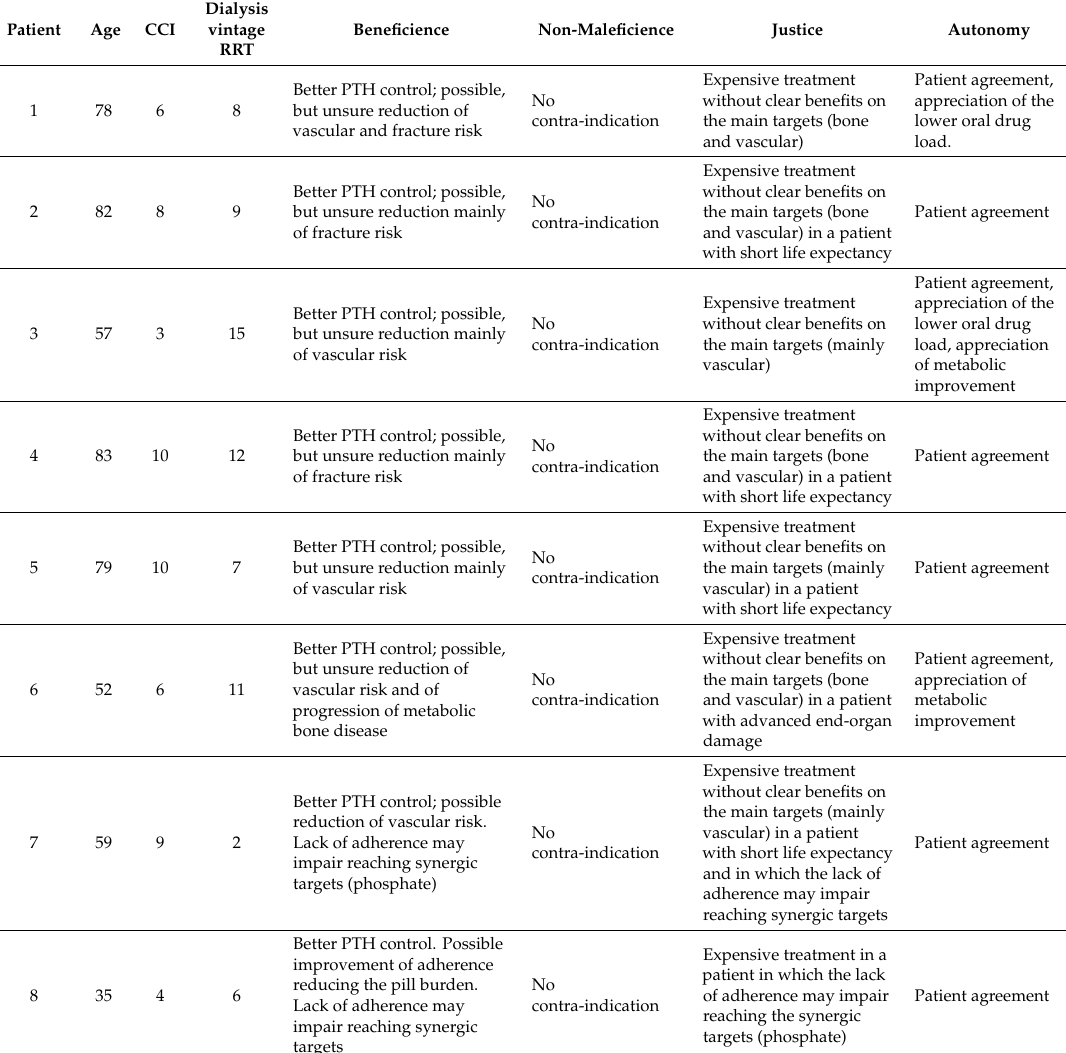
Table 3. An ethical principlist approach to the indications and contraindications to